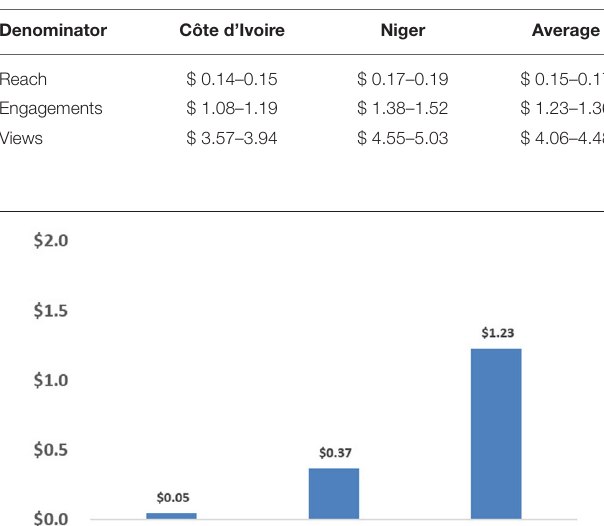
TABLE 4 | Unit costs range of MMH videos.